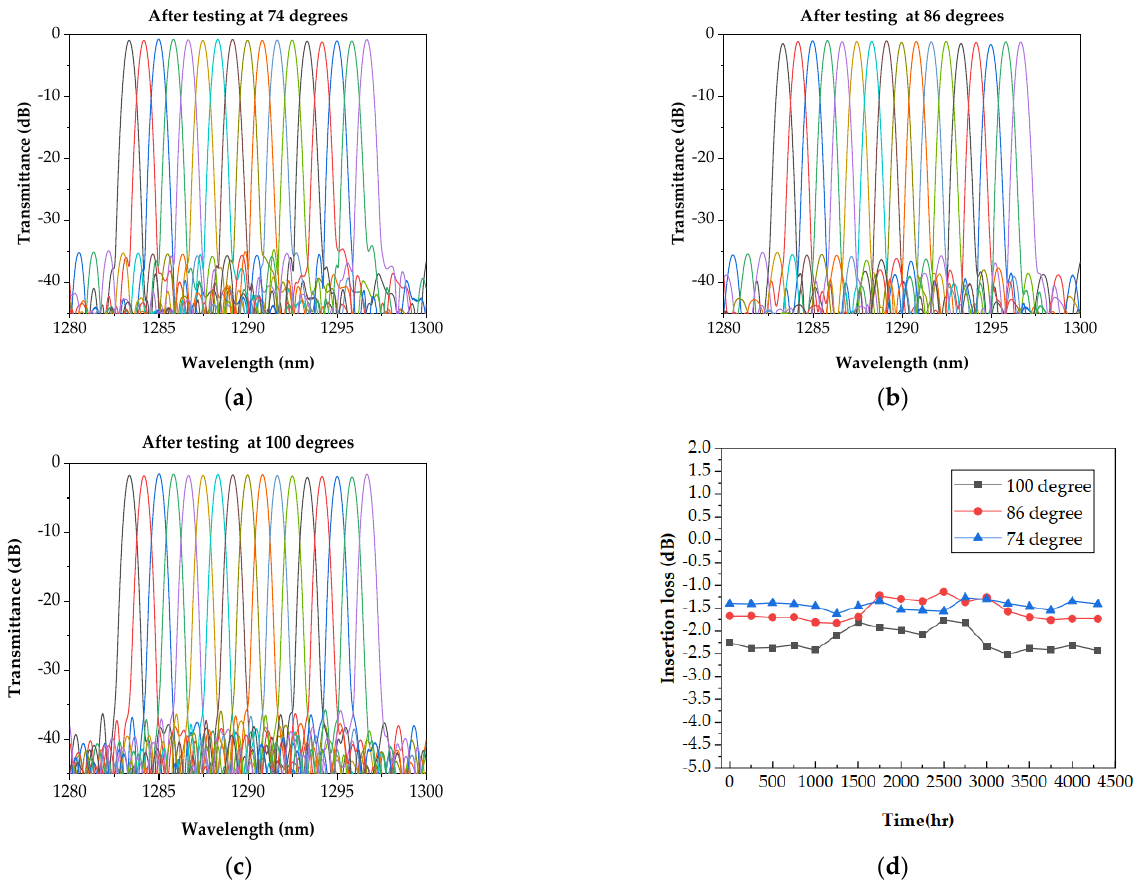
Figure 11. Transmittance and IL deviation after high temperature accelerated life test: ( a ) Transmit- tance for 1 channel at 74 °C; ( b ) Transmittance for 1 channel at 86 °C; ( c ) Transmittance for 1 channel at 100 °C; ( d ) IL for 1 channel at 74 °C, 86 °C, and 100 °C.